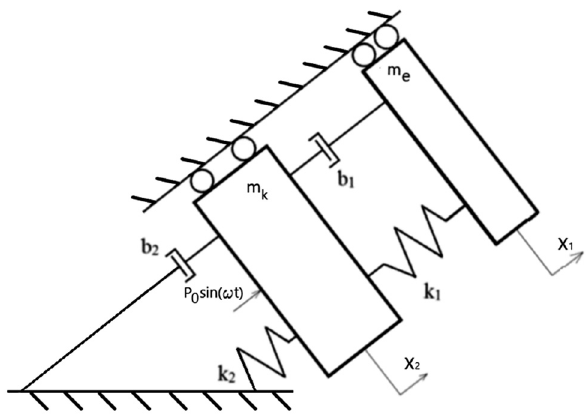
Figure 2: Simpli fi ed two - mass model of the